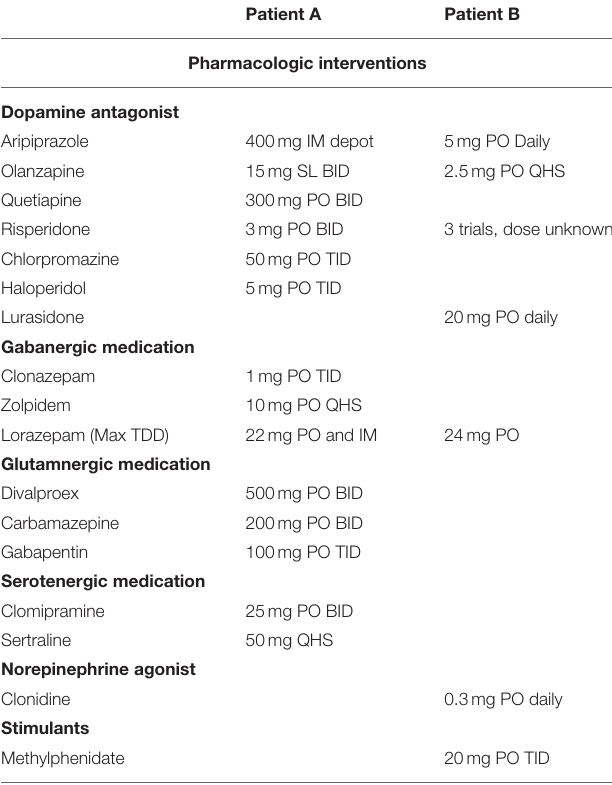
TABLE 1 | Pharmacologic Interventions for each patient. Patient A Patient